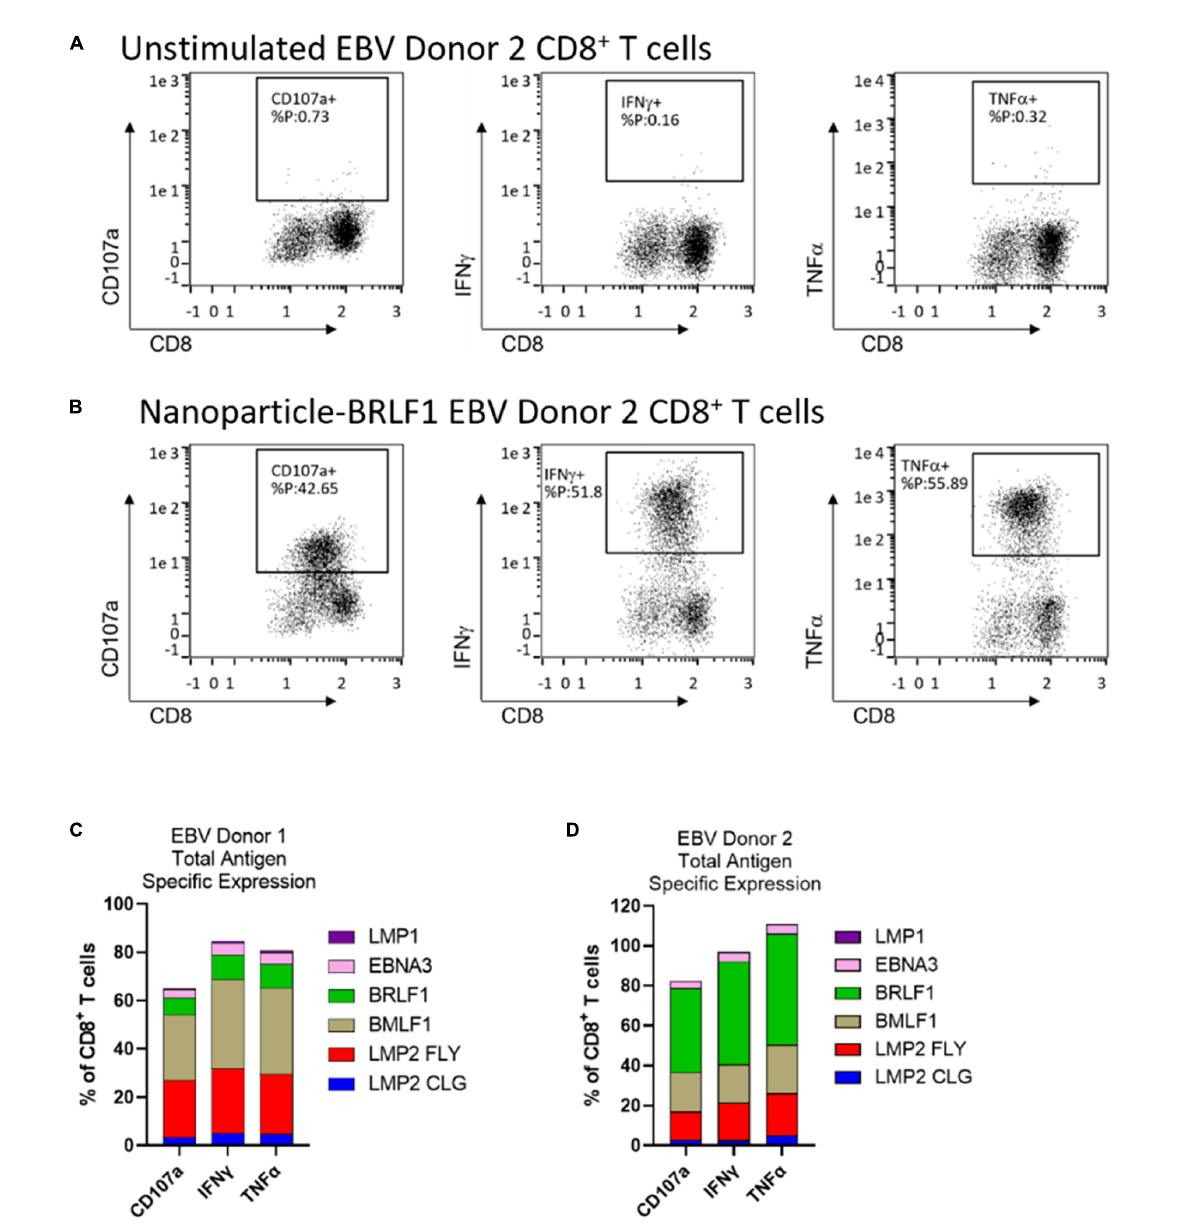
FIGURE4 AIM ACT cells selected on 6 EBV peptides produce a polyfunctional response upon antigen-specific restimulation. Intracellular cytokine staining was run on EBV antigen-specific E+E cells from 2 healthy donors. Cells were left unstimulated or were restimulated with nanoparticles loaded with one of the six EBV peptides. Representative plots show the expression of functional markers by CD8 + T cells from EBV Donor 2 when (A) left unstimulated or when (B) stimulated with BRLF1 loaded nanoparticles. The cumulative percentage of CD8 + T cells from (C) EBV Donor 1 and (D) EBV Donor 2 that express each functional marker in response to stimulation with peptide loaded nanoparticles. Conditions were run in duplicate